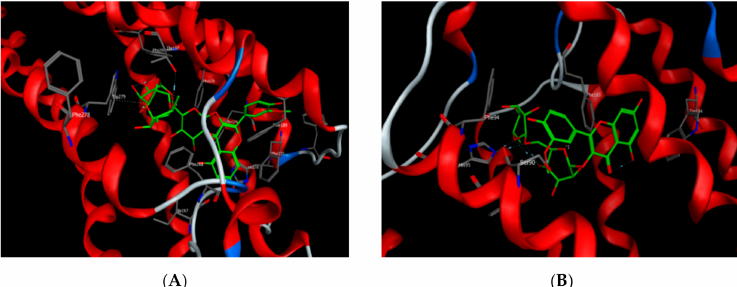
Figure 3. Isorhamnetin-3- O -(2-glucosyl) rutinoside docked onto the CB1-binding site ( A ) and isorhamnetin 3- O - β -glucopyranoside-7- O - α -rhamnopyranoside docked onto the CB2-binding site ( B ).